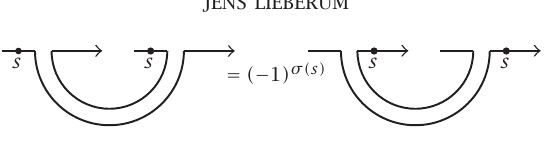
Figure 7.6 . The compatibility of W ob